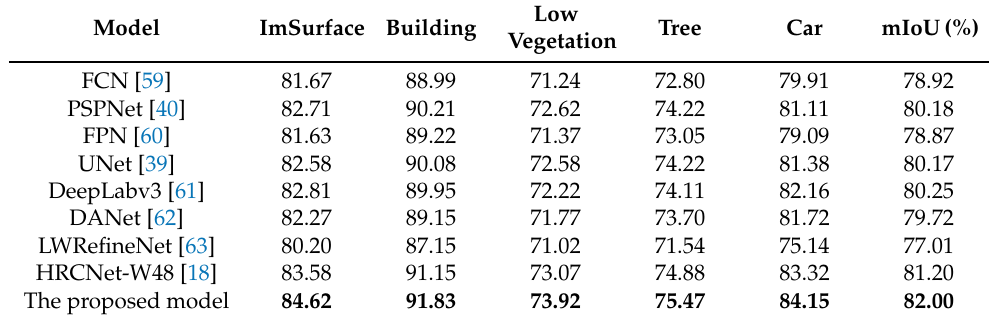
Table 5. The mean intersection over union (%) on the Potsdam dataset with the above models.